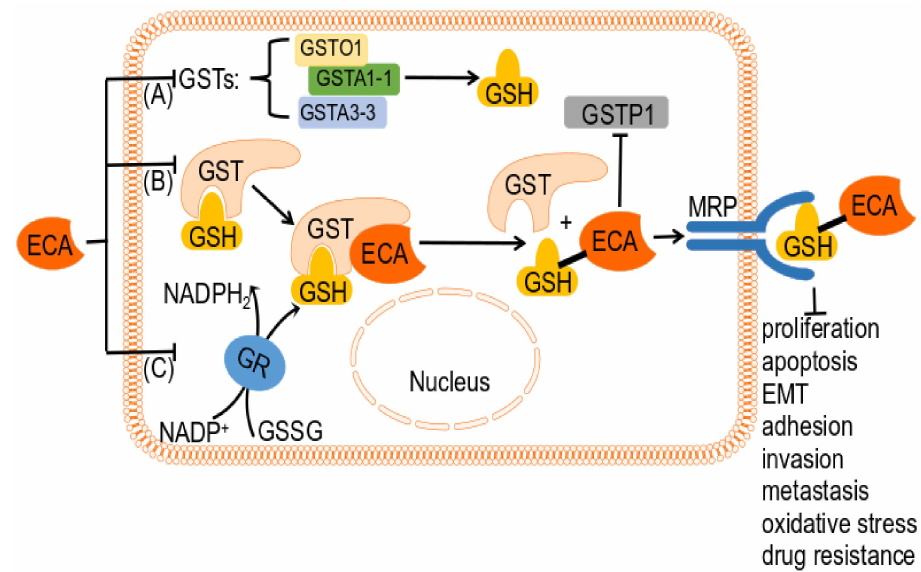
Figure 4. Possible GSH mechanism of ECA in cancers. (A) ECA directly inhibits the activity of GSTs, such as GSTO1, GSTA1-1, and GSTA3-3. (B) ECA can be catalyzed by GST, covalently bound to GSH, and the resulting GSH-ECA conjugate acts as an MRP substrate and inhibits MRP transport. The GSH-ECA complex also inhibits GSTP1-1, resulting in suppressive activity in human tumor cells. (C) ECA affects glutathione reductase (GR) by modulating intracellular GSH levels. Abbreviations: ECA, ethacrynic acid; GST, glutathione S-Transferase; GSH, glutathione; GSTO1, glutathione S- transferase omega-1 (GSTO1); GSTA1-1, glutathione S-transferase alpha 1-1; GSTA3-3, glutathione S-transferase alpha 3-3; GSTP1, glutathione S-transferase Pi 1; GR, glutathione reductase; GSSG, oxidized glutathione; MRP, multidrug resistance